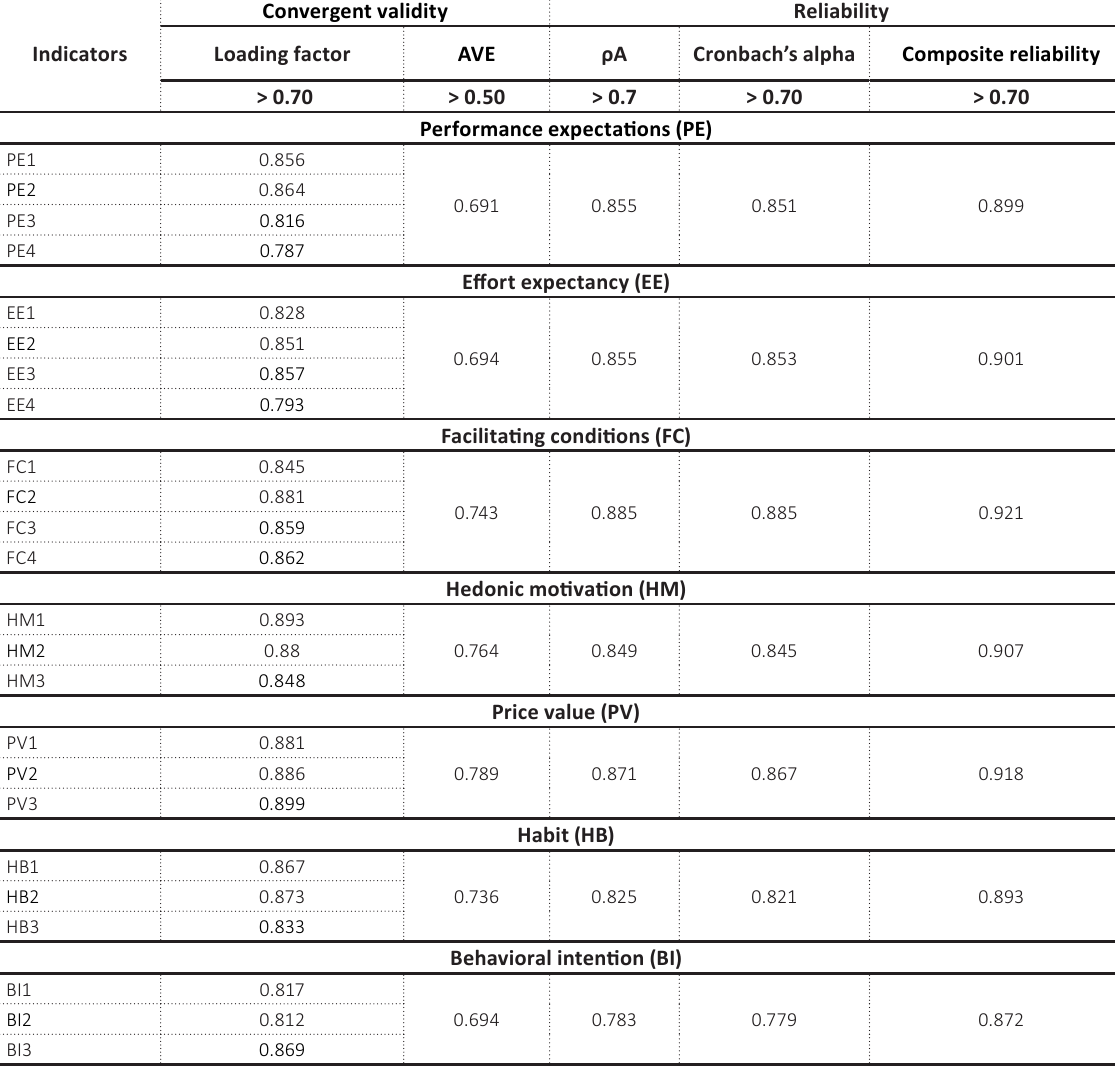
Table 1. Convergent validity and reliability for the reflective indicators